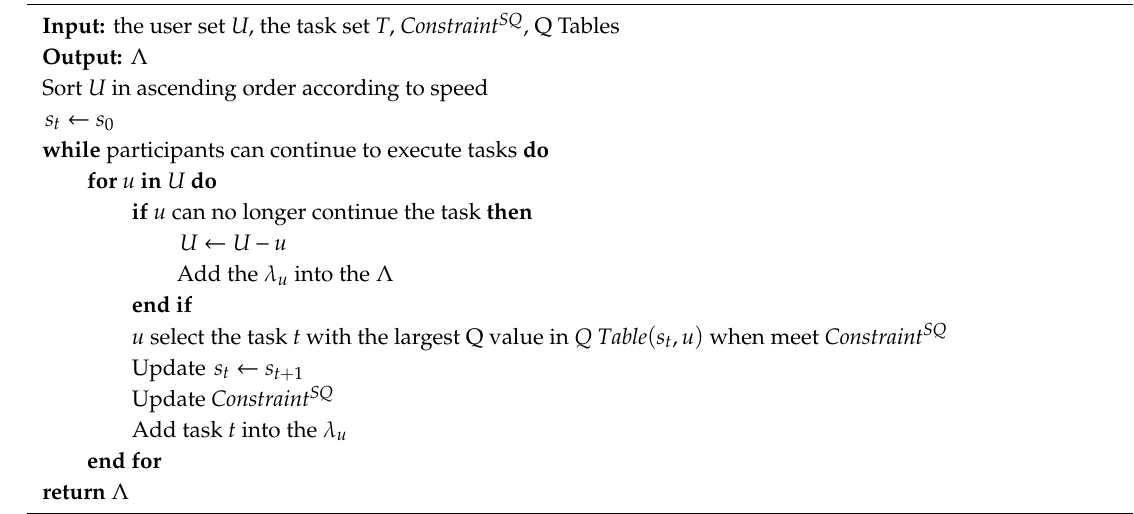
Algorithm 3: Cooperation mechanism based on social convention